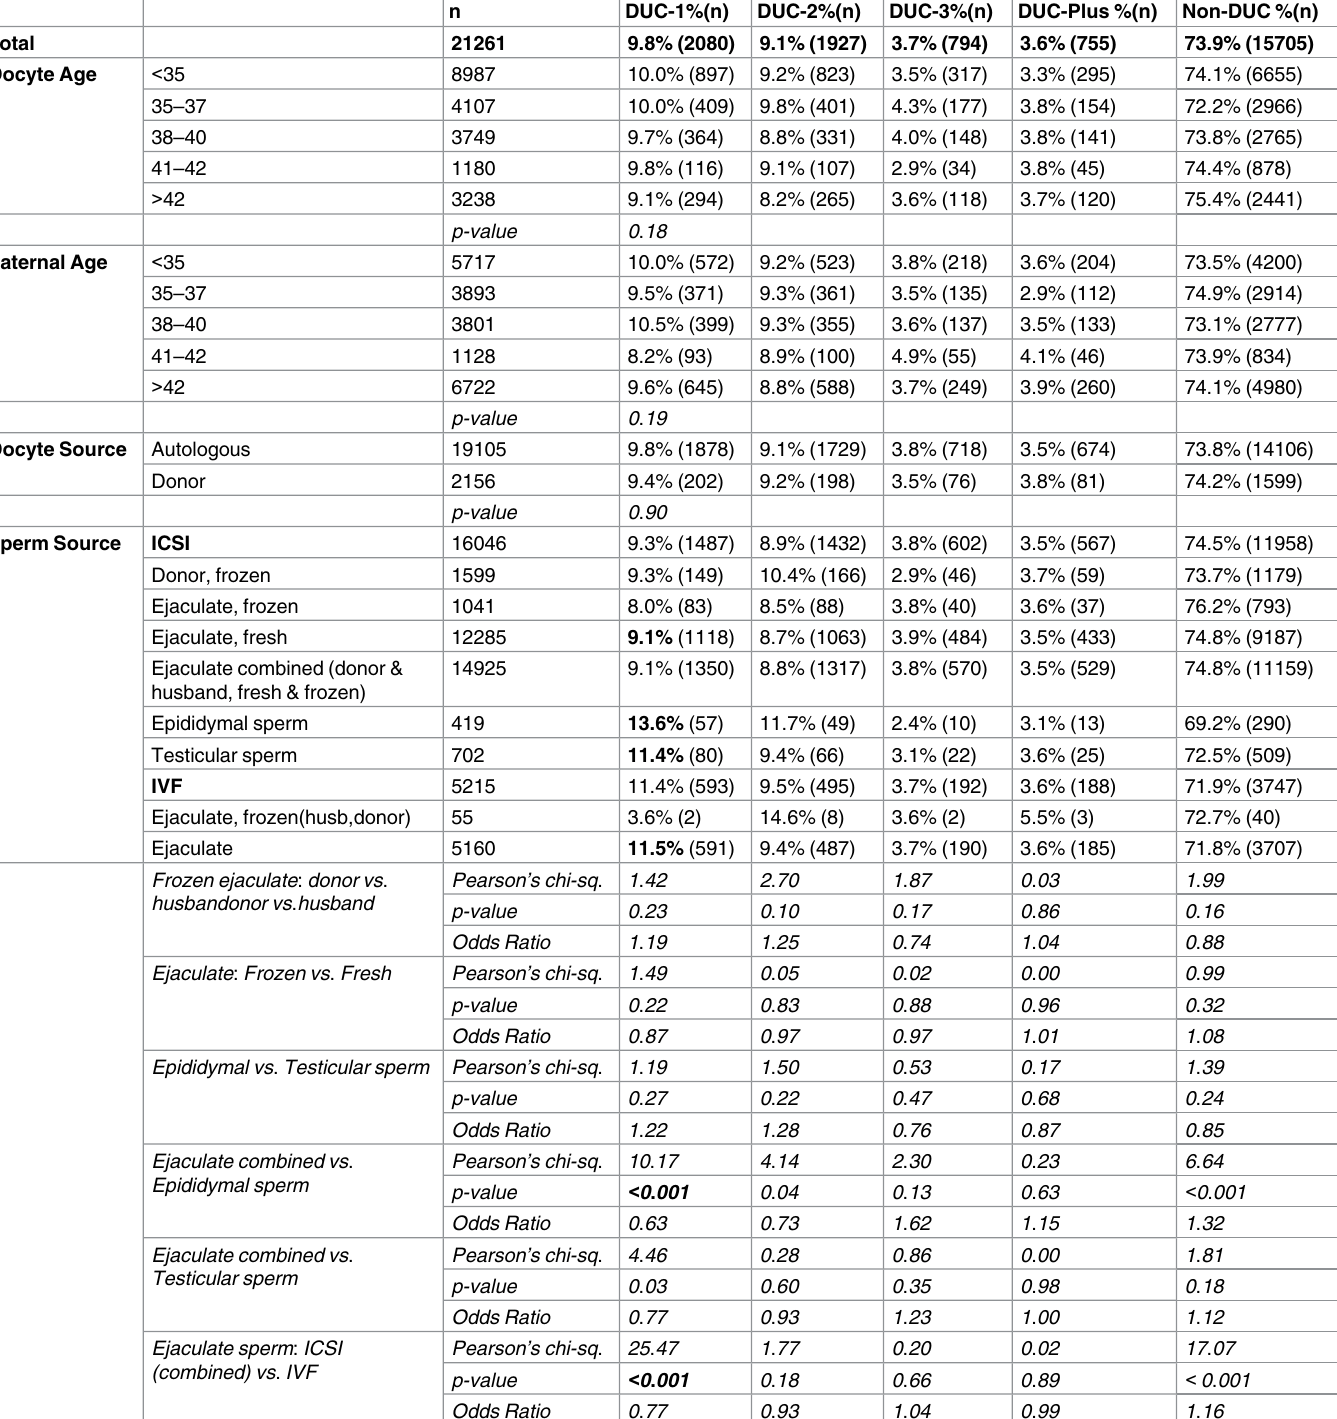
Table 1. DUCs incidence: gamete age, gamete source and oxygen